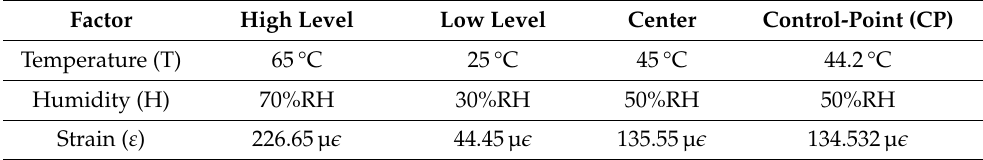
Table 1. High and low levels of the